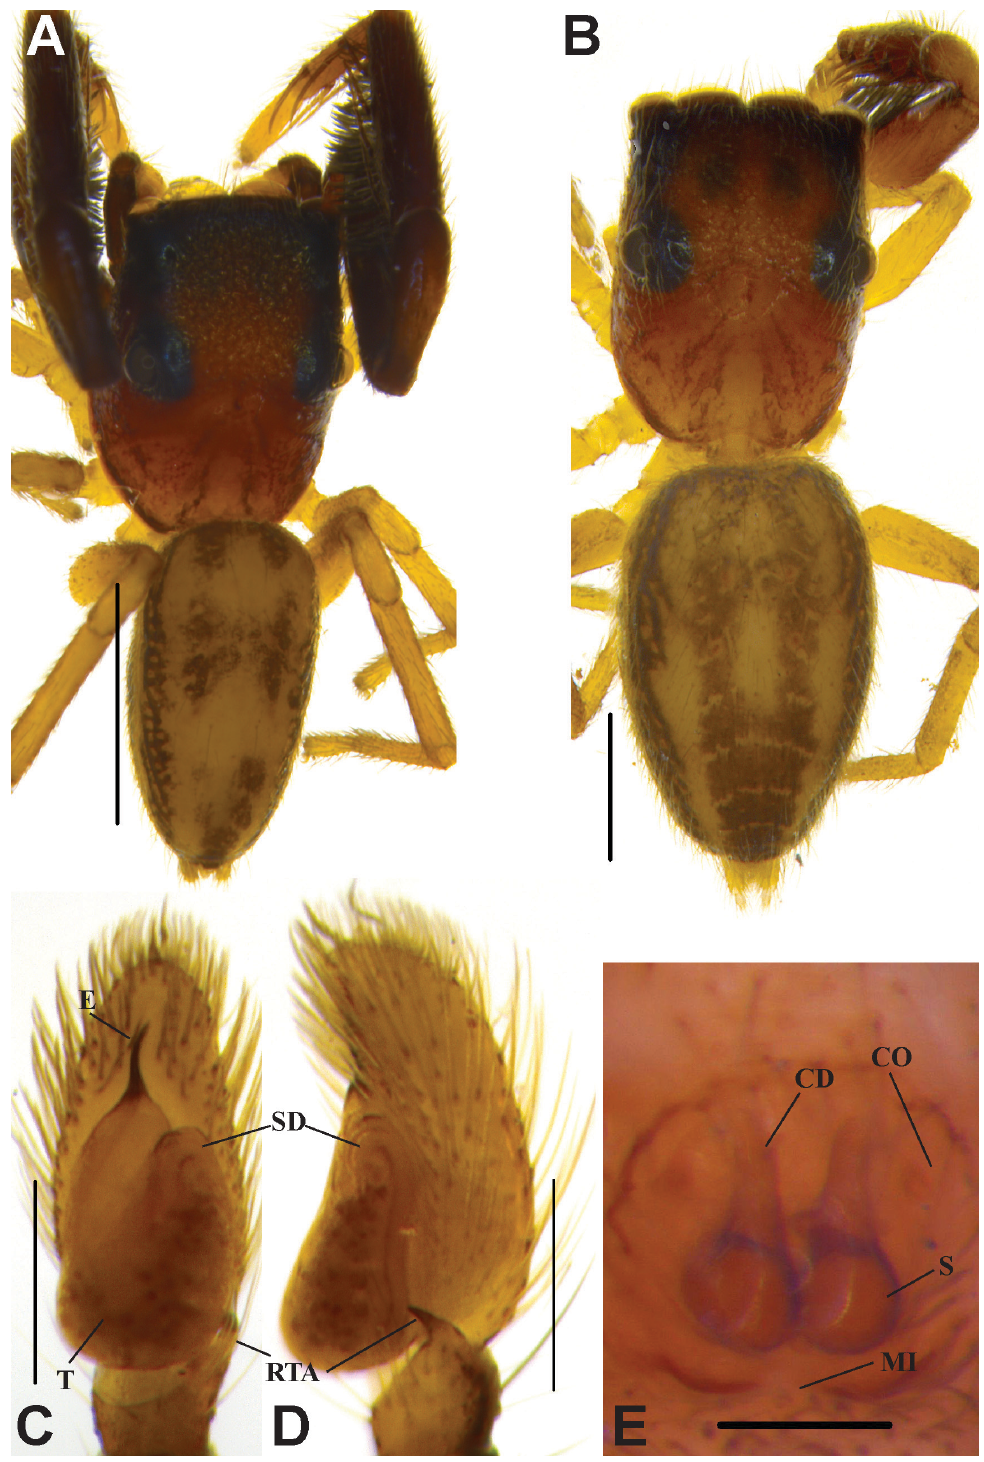
Fig. 3. Bristowia gandhii sp. nov. A, C–D . ♂ (IFS_SAL 228). B, E . ♀ (IFS_SAL 297). A–B . habitus, dorsal view. C . Palp, ventral view. D . Palp, retrolateral view. E . Epigynum, ventral view. Abbreviations: CD = copulatory duct; CO = copulatory opening; E = embolus; MI = median indentation; RTA = retrolateral tibial apophysis; S = spermathecae; SD = sperm duct; T = tegulum. Scale bars: A = 1 mm; B= 0.5 mm; C–E = 0.2